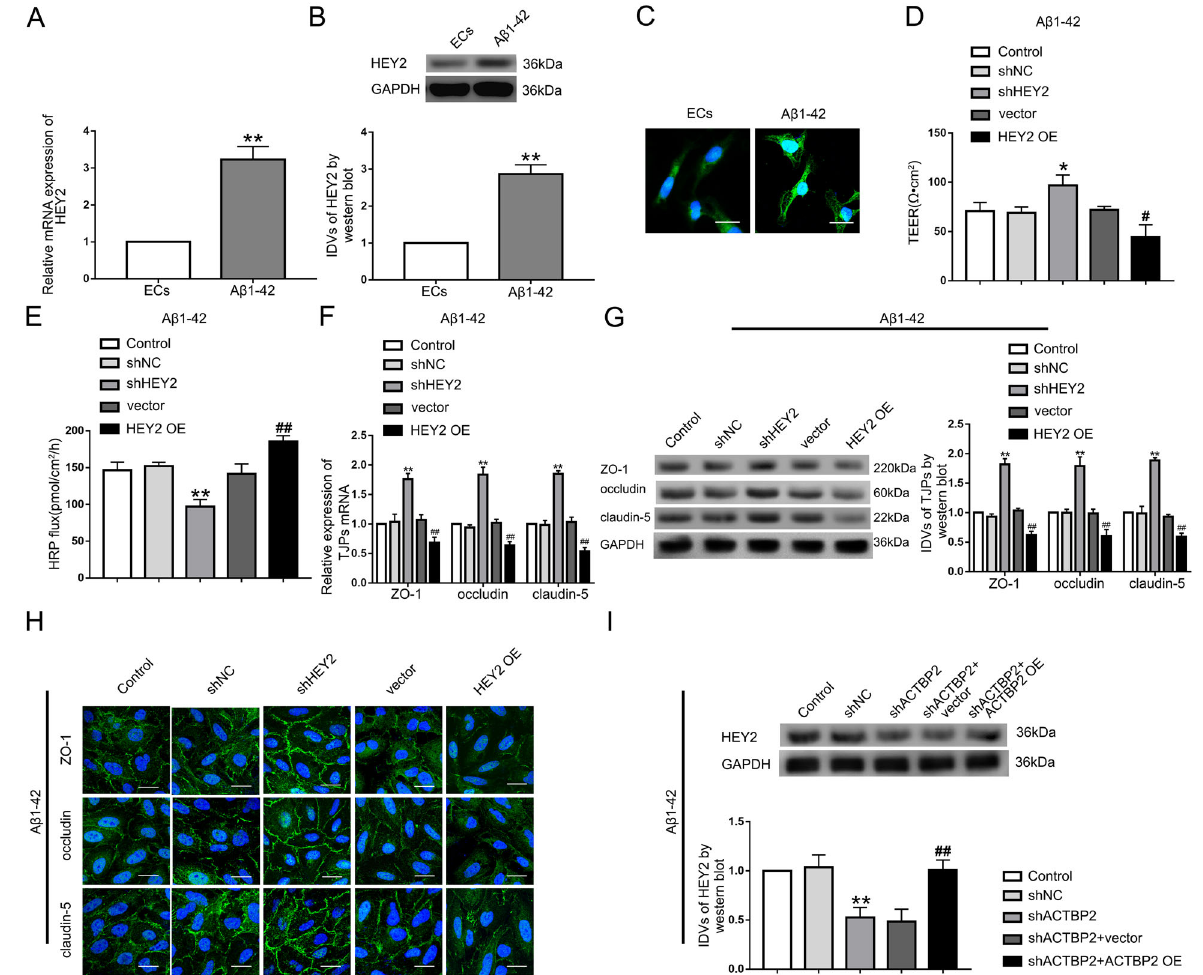
Fig. 4 HEY2 was upregulated in A β 1 – 42 -incubated ECs and increased BBB permeability in A β 1 – 42 microenvironment. A Relative mRNA expression level of HEY2 in ECs pre-incubated with A β 1 – 42 determined by qRT-PCR. B Relative protein expression level of HEY2 in ECs pre- incubated with A β 1 – 42 determined by western blot. Data represent mean ± SD ( n = 3, each). ** P < 0.01 versus ECs group. C Immuno fl uorescence staining analysis of the location of HEY2 (green) in both the nucleus and the cytoplasm of A β 1 – 42 -incubated ECs. Scale bar represents 30 μ m. D , E Effects of HEY2 on TEER values ( D ) and HRP fl ux ( E ) in A β 1 – 42 microenvironment. F Effects of HEY2 on ZO-1, occludin, and claudin-5 expression levels in A β 1 – 42 -incubated ECs determined by qRT-PCR. G Effects of HEY2 on ZO-1, occludin, and claudin-5 expression levels in ECs pre-incubated with A β 1 – 42 determined by western blot. Data represent mean ± SD ( n = 3, each). * P < 0.05 versus shNC group. ** P < 0.01 versus shNC group. # P < 0.05 versus vector group. ## P < 0.01 versus vector group. H Immuno fl uorescence assays were used to determine ZO-1, occludin, and claudin-5 (green) expression levels and distribution, respectively, in A β 1 – 42 microenvironment. Scale bar represents 30 μ m. I Effects of ACTBP2 on HEY2 expression by western blot. Data are presented as mean ± SD ( n = 3). ** P < 0.01 versus shNC group. ## P < 0.01 versus shACTBP2 + vector